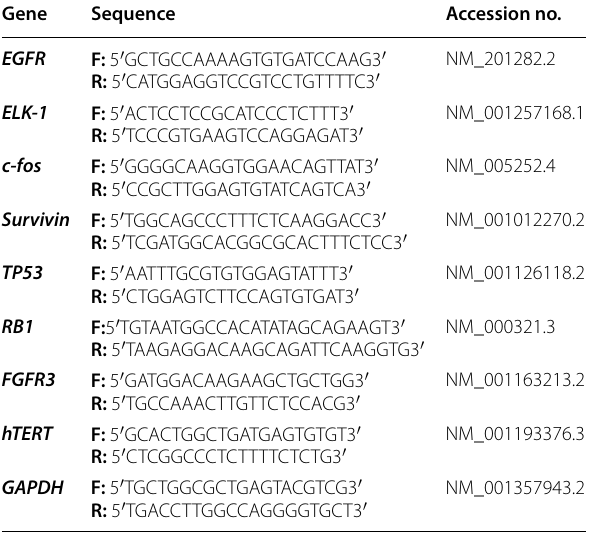
Gene Sequence Accession